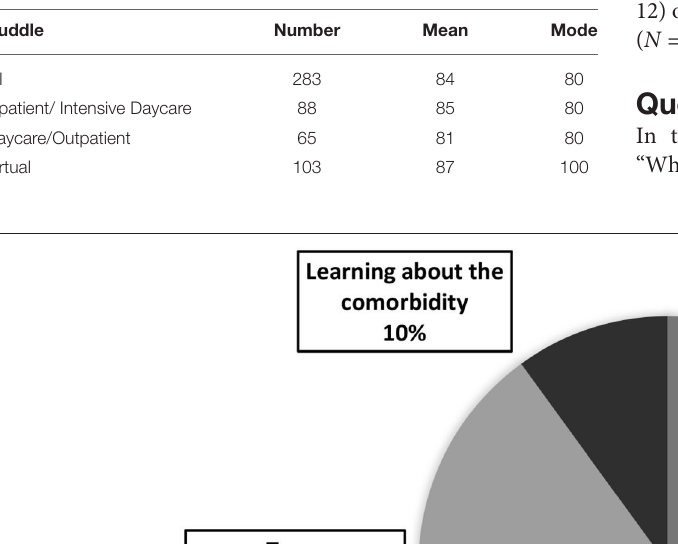
TABLE 1 | A table showing the N, M, and Mode weekly responses in each huddle forum to “How useful /100 was the huddle.”